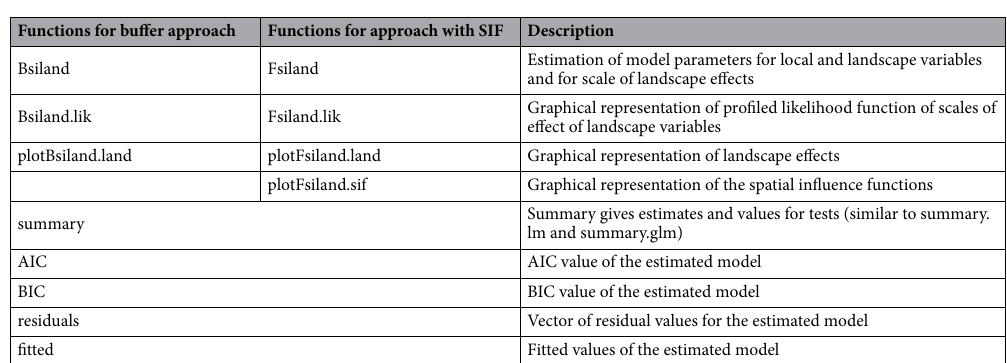
Table 1. Main functions of siland package. Detailed information about these functions are given in https:// cran.r- proje ct. org/ web/ packa ges/ siland/ siland.